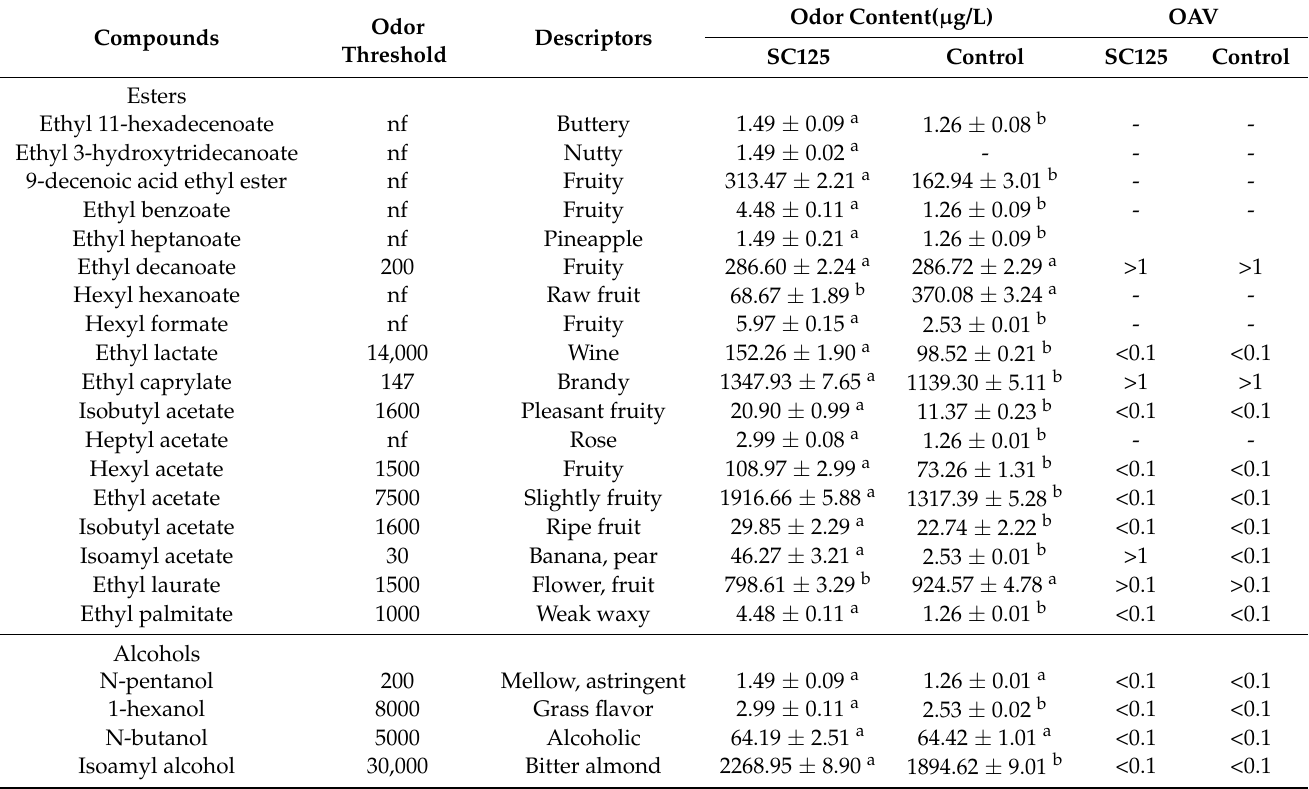
Table 1. Volatile compound profiles of apple beverages identified by HS-SPME/GC-MS ( µ